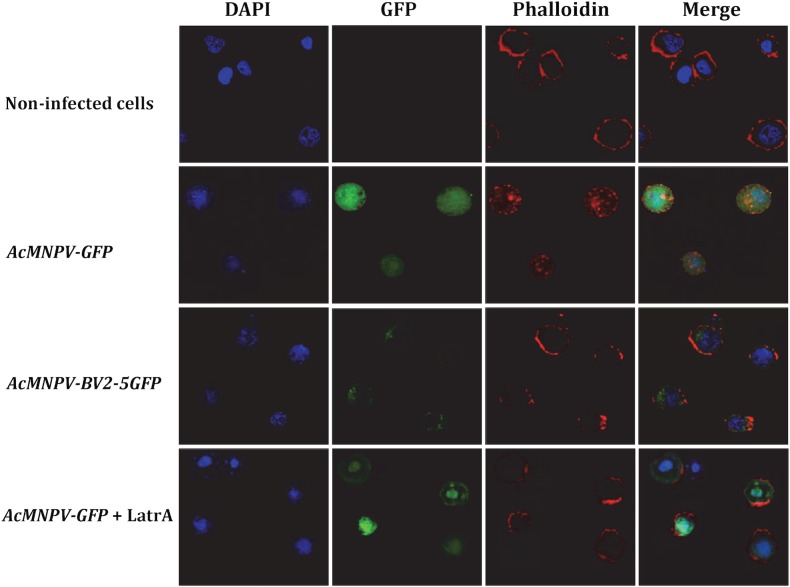
Cellular localization of BV2-5 and its effect on actin distribution.Sf21 cells were infected with different recombinant viruses. The upper horizontal panel represents non-infected cells and the rest represent cells infected with AcMNPV-GFP, AcMNPV-BV2-5GFP and AcMNPV-GFP treated by latrunculin A, respectively. The fluorescence was visualized by confocal microscopy. Nuclei are visualized by DAPI and actin is visualized by phalloidin-TRITC staining.